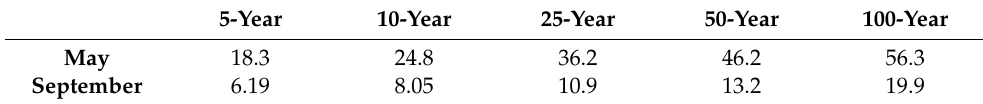
Table 6. Values of reference peak discharge (m 3 /s) under different design